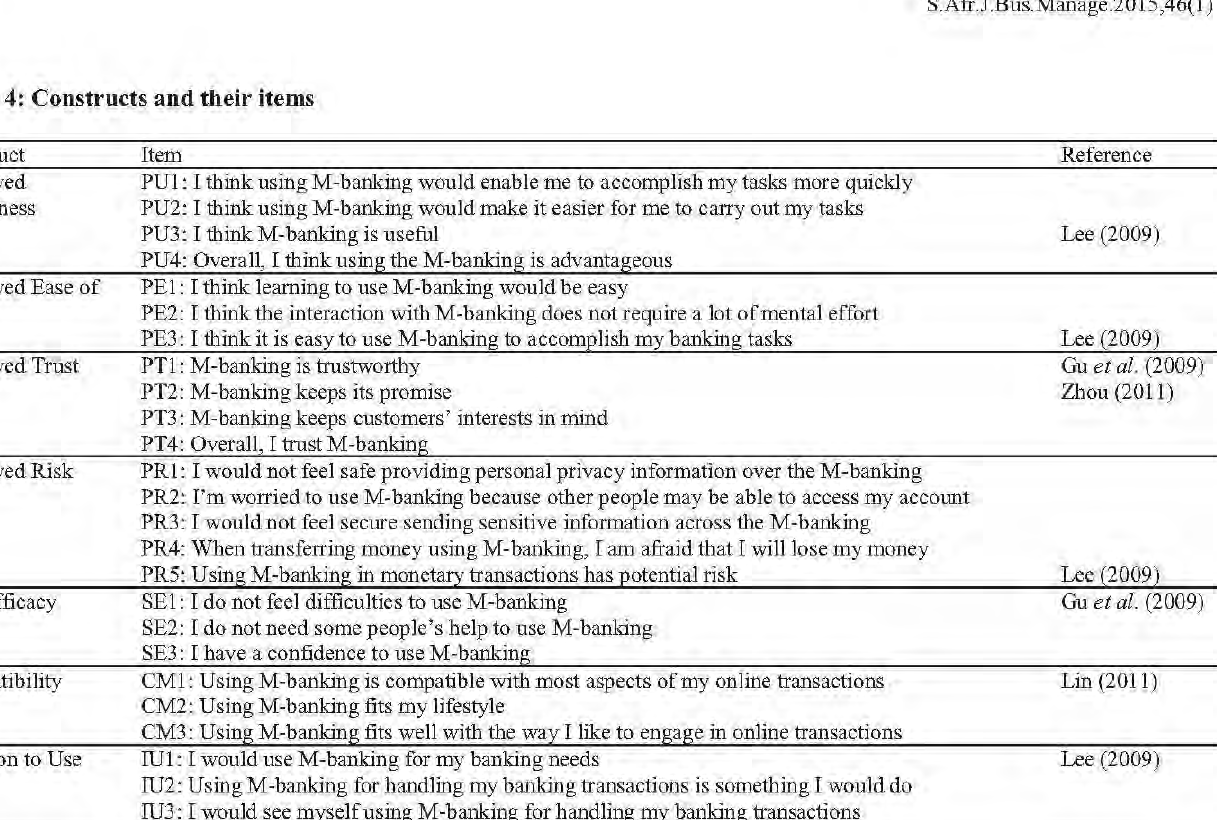
Table 6 summarized the use of mobile banking services by bank customers. Nine to eleven percent indicated that their banks have not offered mobile banking services. The majority have not used mobile banking services. All these mobile services are offered via different channels like ATM, Table 5: Demographic characteristics of the respondents Variable